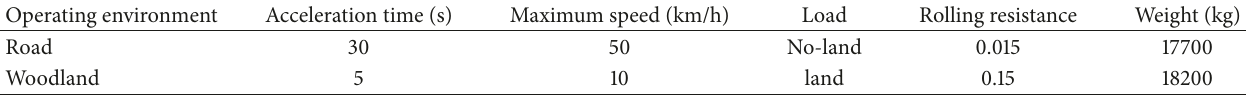
Table 2: Basic parameters of the hybrid power